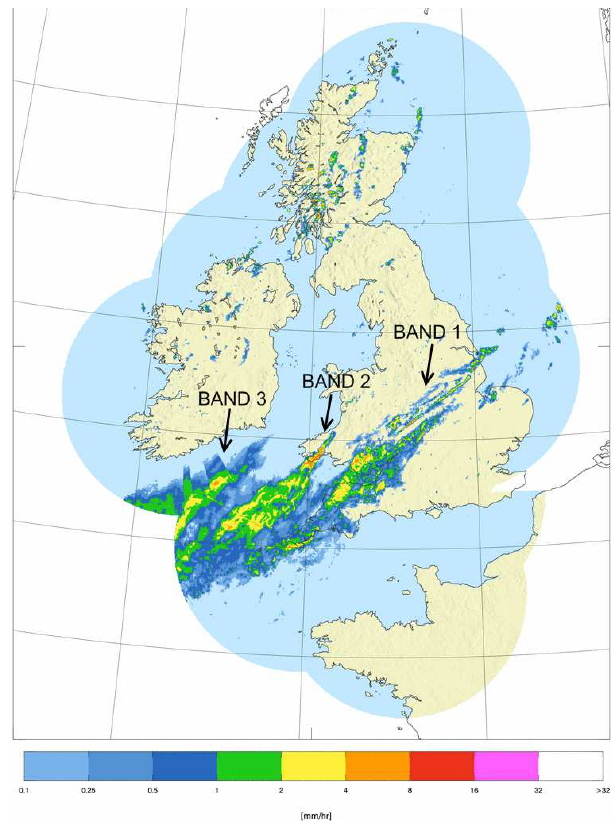
Fig. 4. Radar-derived surface precipitation rate (1km composite) at 15:00UTC 20 September 2011. © Crown Copyright 2011, Met